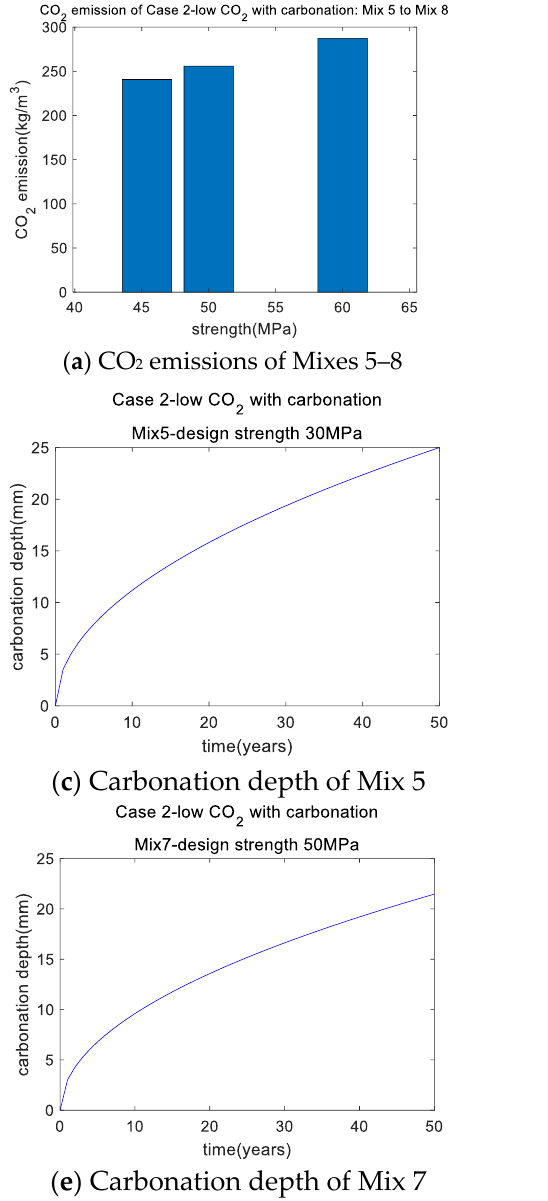
Figure 3. Performance of Case 2: Mixes 5 – 8 (low CO 2 with carbonation). Table 10. Optimal design mixtures for Case 3: low-material-cost concrete with carbonation (unit: kg/m 3